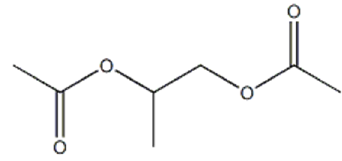
Figure 1. Structural formula of PGDA